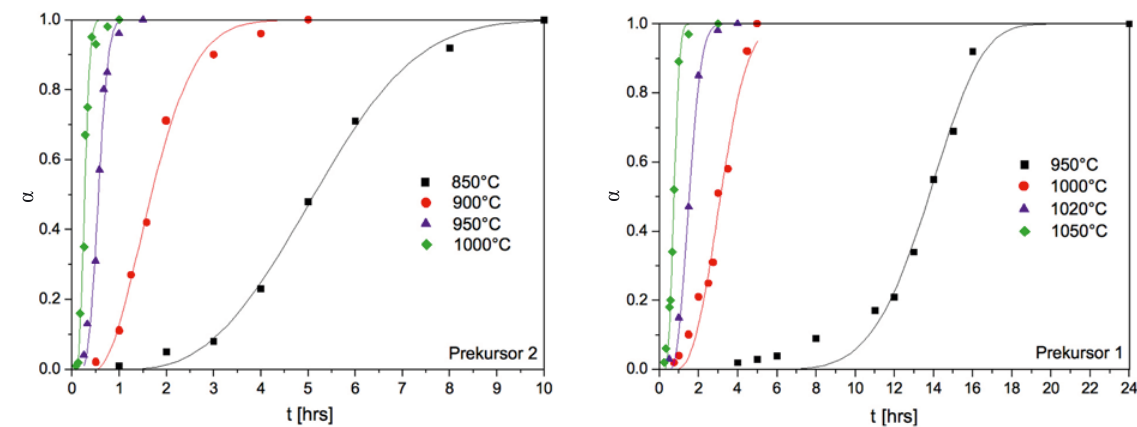
Figure 3. Crystallization kinetics curves of non-seeded and seeded precursor. Table 1. Avrami-Eroféev parameters and induction times for leucite synthesized from P1 and P2. Temperature